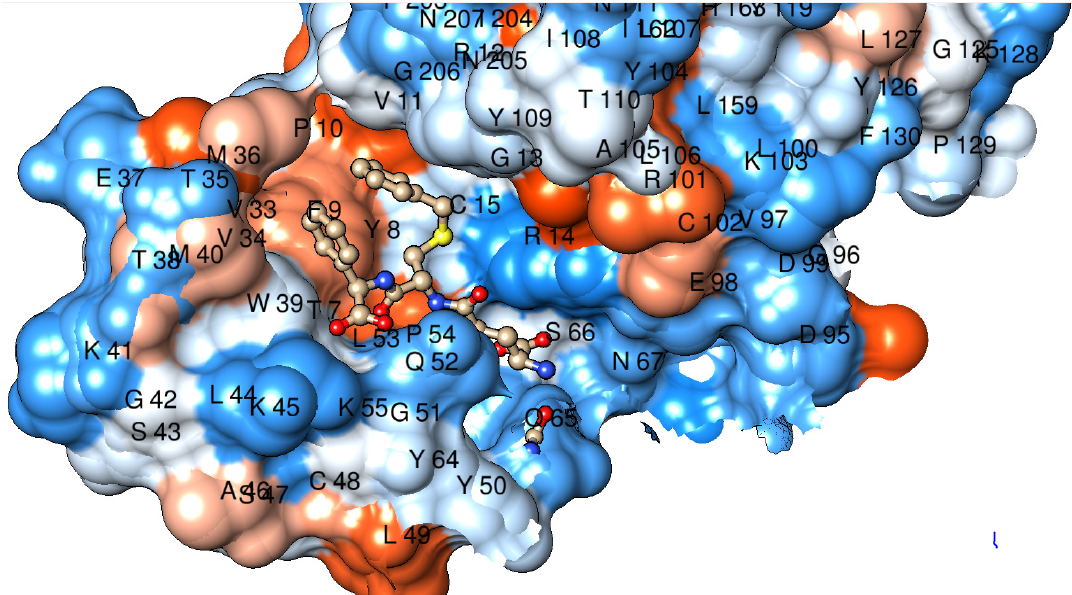
Figure 7. Structure of dog GST P1-1 in complex with TLK117, which features the same peptide backbone as Telcyta. The subunit of the enzyme is shown with atoms as spheres and the bound ligand in ball and stick representation. The benzyl group visible on the sulfur of TLK117 would be replaced by the bulky alkylating moiety in Telcyta. The model constructed in Modeller is based on the corresponding human crystal structure PDB ID: